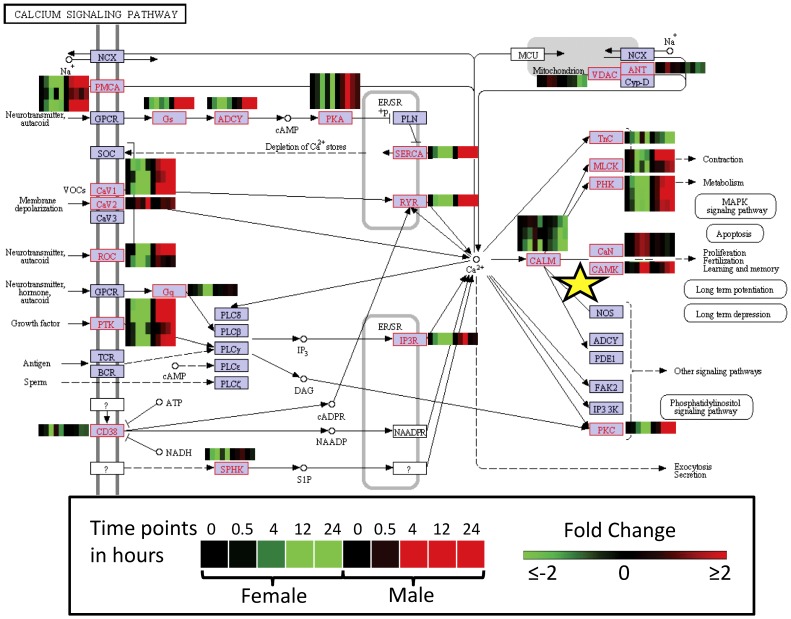
Calcium Signalling Pathway according to KEGG for S. japonicum with corresponding heat maps indicating differential gene expression (≥ or ≤2 fold) after in vivo exposure of adult male and female parasites with praziquantel for 0, 0.5, 4, 12, 24 h.CamKII is marked with a yellow star.